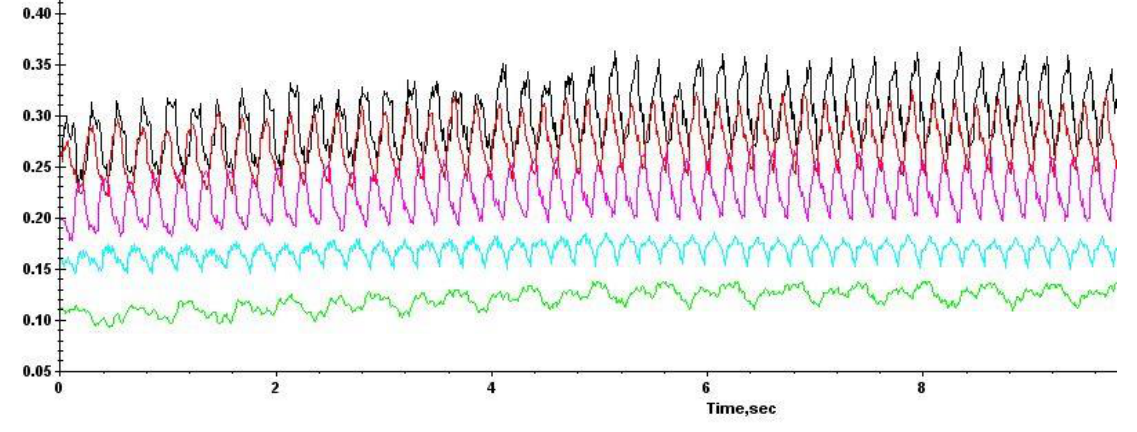
Figure 25. Friction coefficient test curve for the valve plate on CETR UMT-3. The green line represents